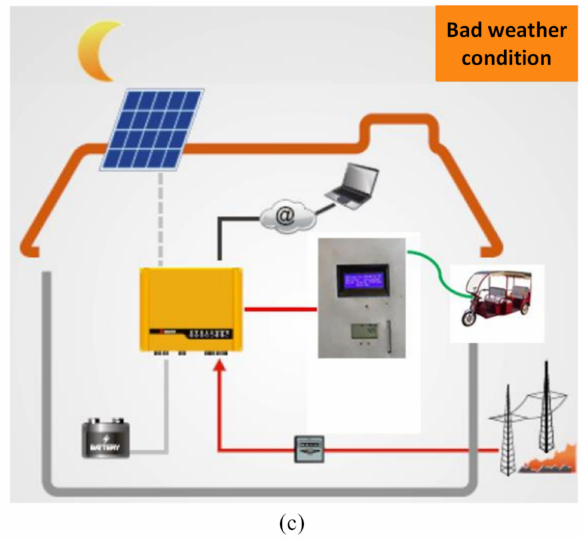
Figure 18. A tri-directional energy flow of solar energy at solar charging stations: ( a ) directly charges the vehicle during day time, ( b ) the system automatically switches to energy from the storage batteries during night time, and ( c ) during bad weather condition, if the battery capacity is insufficient, the system automatically switches to energy from the main grid.